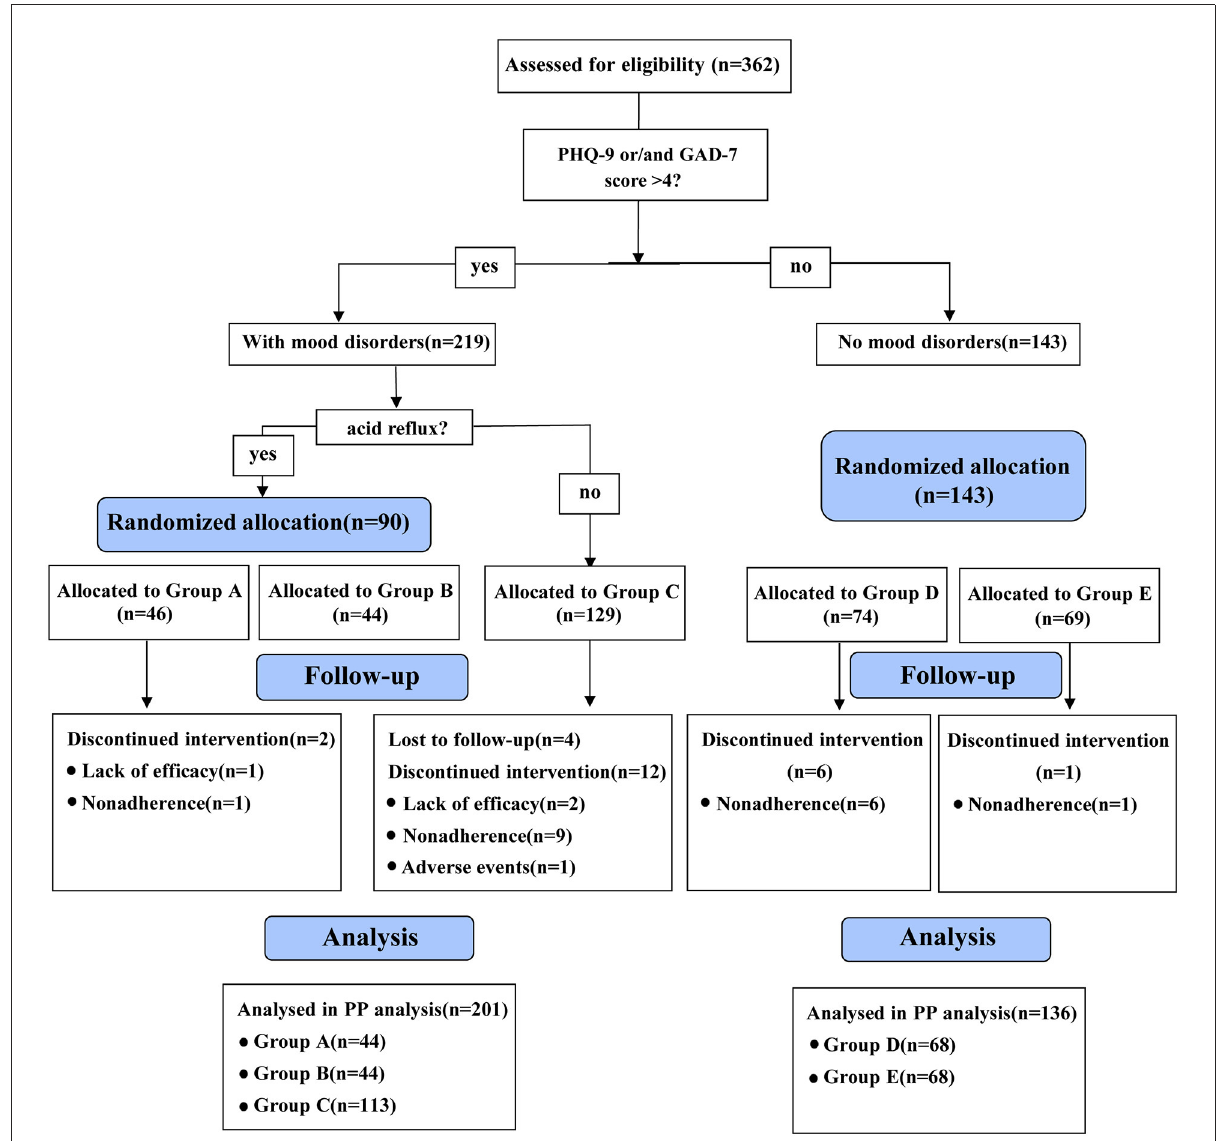
FIGURE1 Flowchart of the recruitment and assignment of patients with functional dyspepsia. PHQ-9, patient health questionnaire-9; GAD-7, generalized anxiety disorder-7; Group A: flupentixol and melitracen + nizatidine; Group B: flupentixol and melitracen + rabeprazole; Group C: flupentixol and melitracen. PP, per